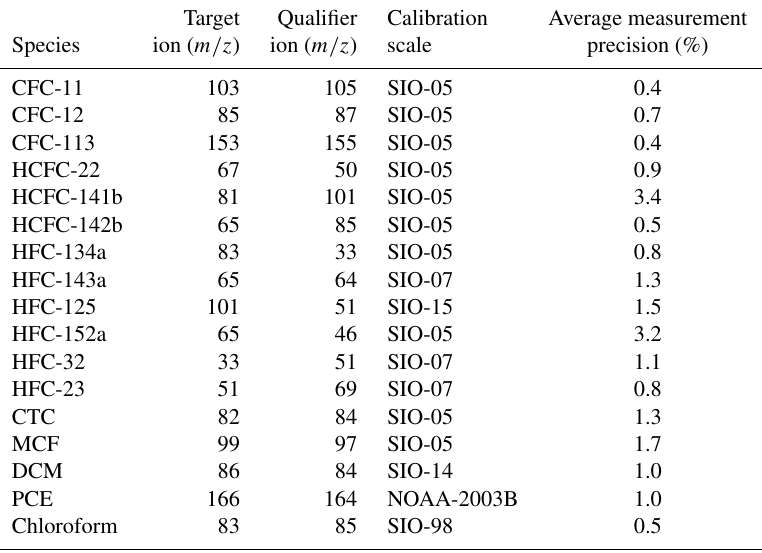
Table 3. Halocarbon mass spectrometry target and qualifier ions and respective calibration scales. SIO: Scripps Institution of Oceanography, NOAA: National Oceanic and Atmospheric Administration. Average flask measurement precision is also shown.